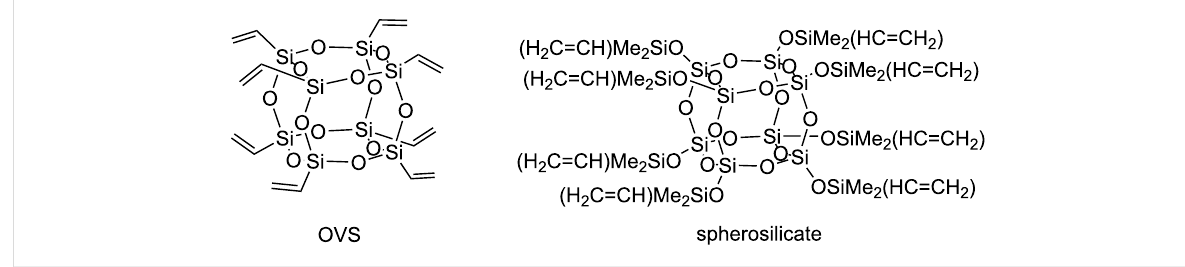
Figure 4: Octavinyl-substituted cubic silsesquioxane (OVS) and spherosilicate.